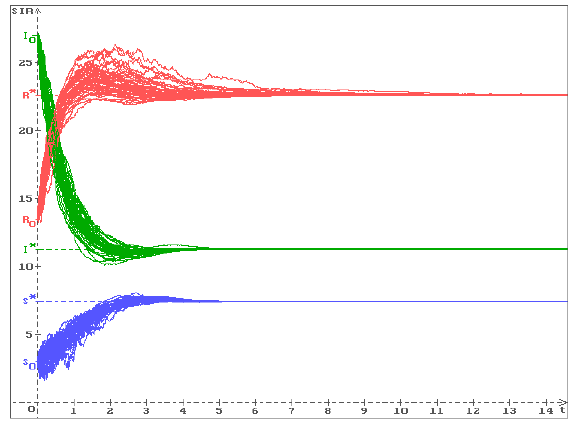
Figure 2. 50 trajectories of the solution of the system (6): S ( t ) (blue), I ( t ) (green), R ( t ) (red) with the initial values S ( 0 ) = 3, I ( s ) = 27, s ∈ [ − h ,0 ] , R ( 0 ) = 13.5 in the point A ( δ 1 , δ 2 ) = A ( 1,0.16 ) , δ 3 = 0.45, h =